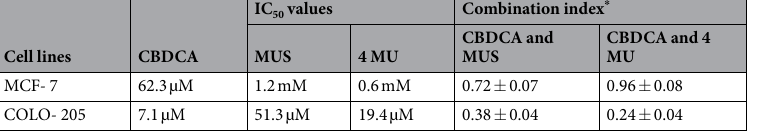
Table 2. Determination of IC 50 values and Combination Index by MTT assay. Mean values calculated from combination indices achieved in the IC 25 –IC 75 range of